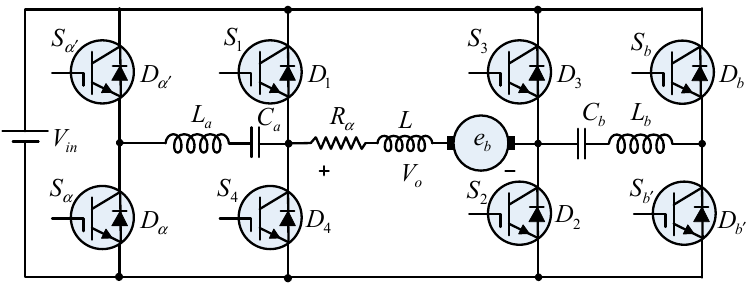
Figure 17. 4Q-ZCT converter fed DC motor drive .